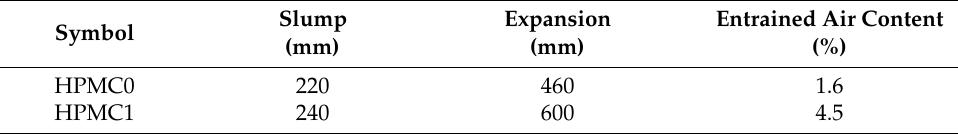
Figure 2. Changes of concrete workability before and after adding HPMC. Table 6. Multiple indexes of concrete